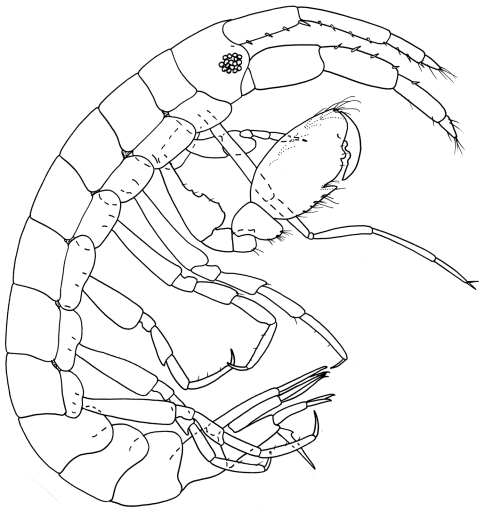

Colomastix lecroyaesp n., male